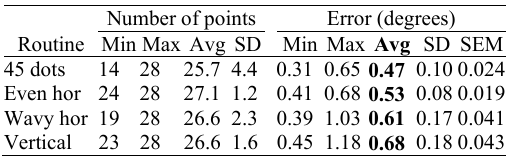
Table 2 also shows the average error across the 28 val- idation points and 17 participants per calibration routine. The important column that needs to be interpreted to com- pare the four calibration routines is boldfaced. Figure 4 provides a visualisation of the same results. The vertical bars denote the 95% confidence intervals of the means. Table 2 Average number of validation points that was included and the average error (over participants and validation targets) for each of the calibration routines. (SD: Standard deviation, SEM: Standard error of the mean) Number of points Routine